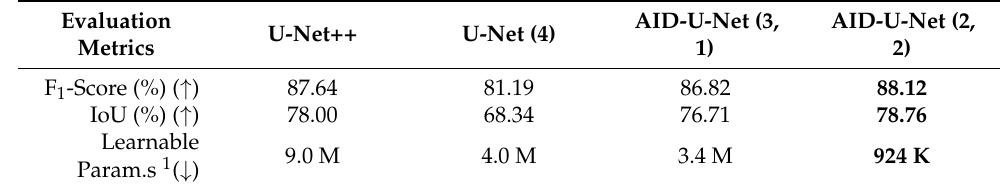
Table 4. Comparative results between U ‐ Net with depth 4, AID ‐ U ‐ Net (3, 1) and AID ‐ U ‐ Net (2, 2) applied to images of colon capsule endoscopy (CCE) for colorectal polyp segmentation.